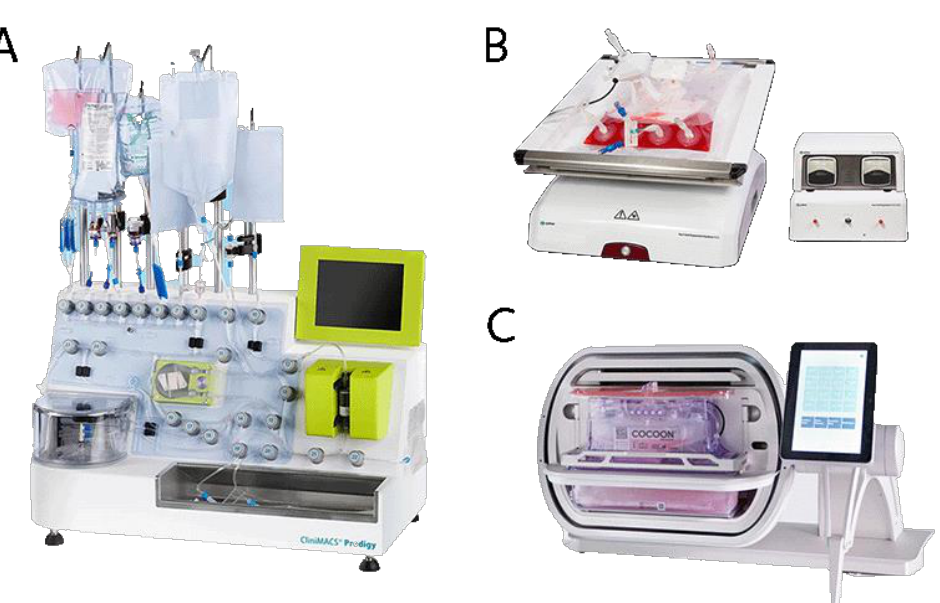
Figure 3. The ( A ) CliniMACS Prodigy, ( B ) Xuri cell, and ( C ) Cocoon, standalone closed bioreactor systems, edited from [36 – 38].